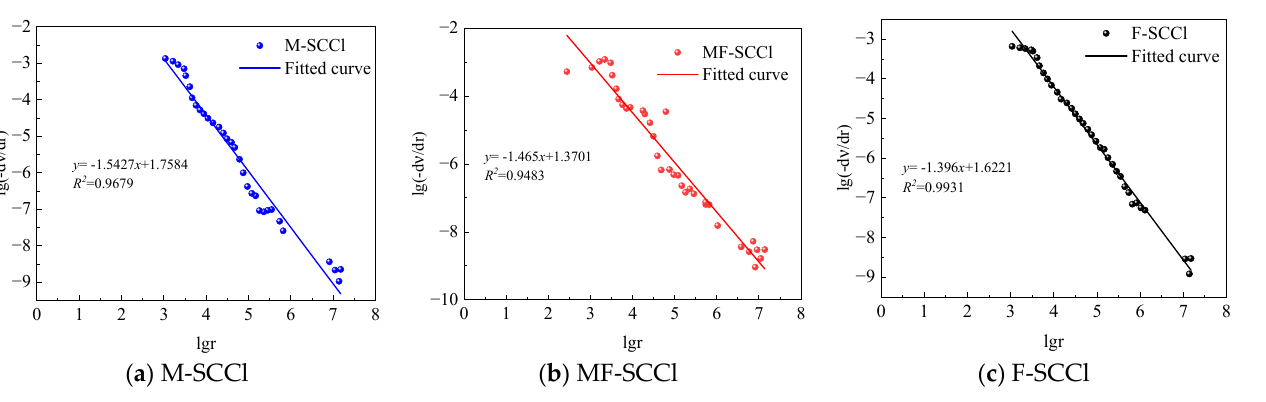
Figure 10. Fitting diagram for pore volume fractal dimension calculation.